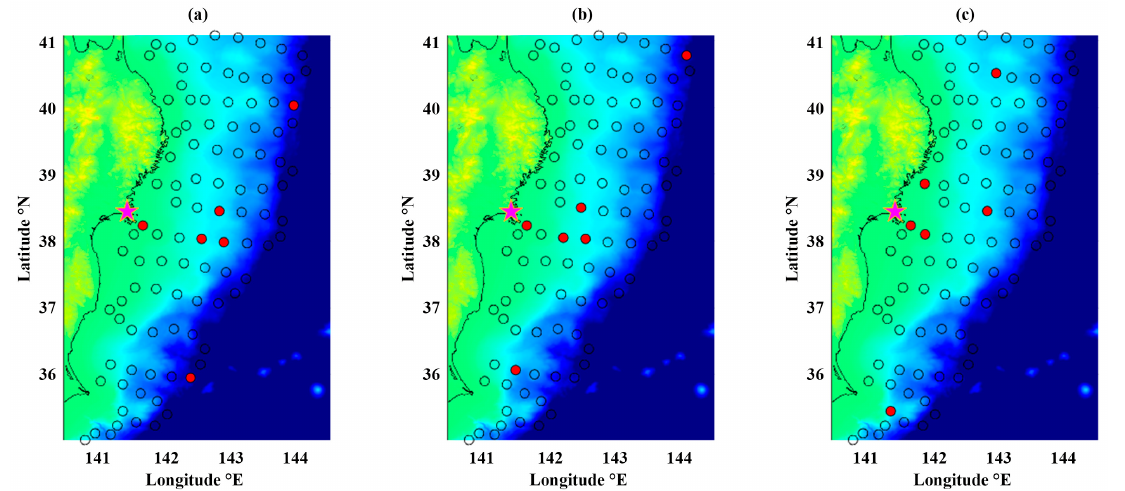
Figure 12. Spatial maps of sensors for the hazard-based early warning in Onagawa: ( a ) 5 min, ( b ) 10 min, and ( c ) 20 min. The pink star represents the target location (Onagawa). The red and empty circles represent the selected and unselected sensors, respectively.